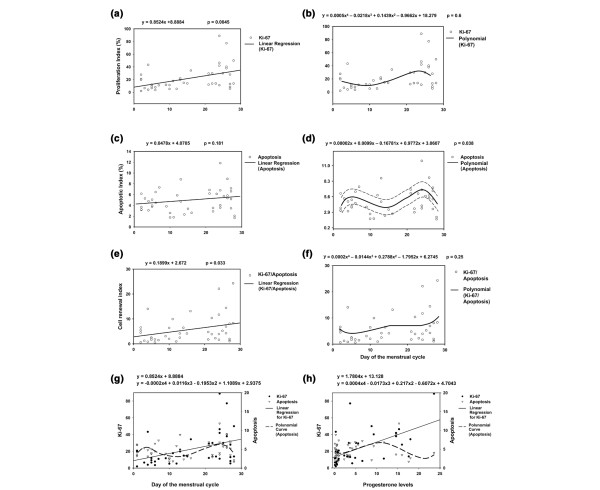
Linear regressions and polynomial curves for the proliferation index (a,b), apoptotic index (c,d) and cell renewal index (e,f). The graphs that best represent the proliferation and the apoptotic indexes were the linear regression (a,c,e) and the polynomial curve (b,d,f), respectively. (g) By superimposing the data after mathematically adjusting the mean visible time of Ki-67 expression [53] with that of the apoptotic index, one confirms that the maximum values for both indices coincide at about day 24 of the menstrual cycle (the point at which the linear regression and polynomial curves are tangential). (h) Correlation of progesterone levels with apoptosis and proliferation irrespective of the stage of the menstrual cycle.